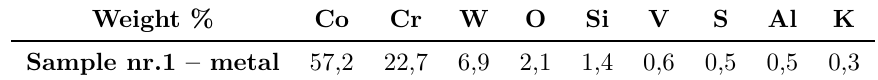
Table 2. Chemical composition of the metal part of the crown obtained by EDX analysis